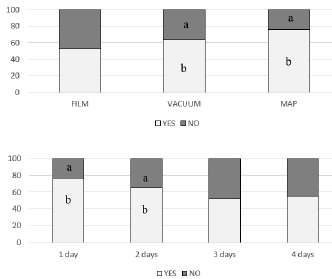
Figure 2. Percentages of purchase intention in function of packaging type and exposure time. a,b Di ff erent letters means significant p value ( p < 0.05) for X 2 test inside a packaging type or inside a exposure